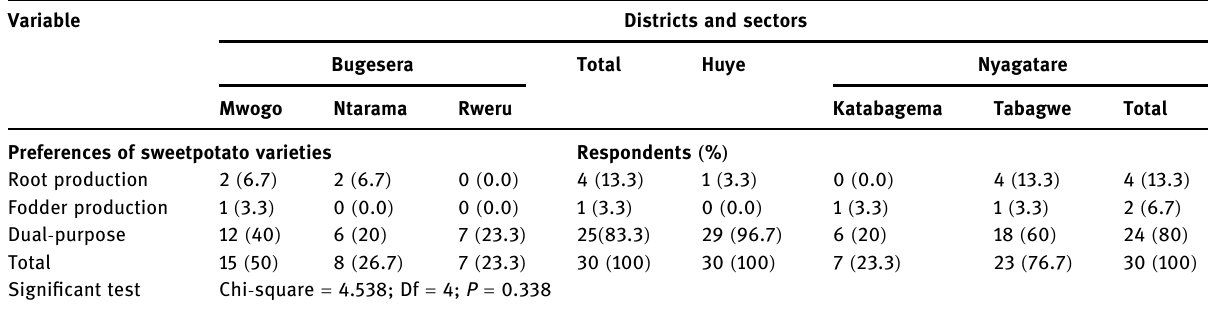
Table 4: Preferences of respondents ( % ) for sweetpotato varieties for root, fodder, or dual - purpose production in three selected districts of Rwanda Variable